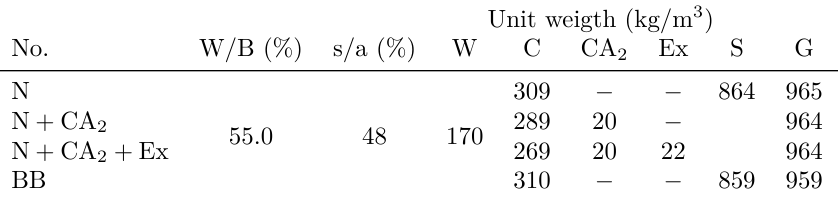
Table 2. Concrete mix proportion.